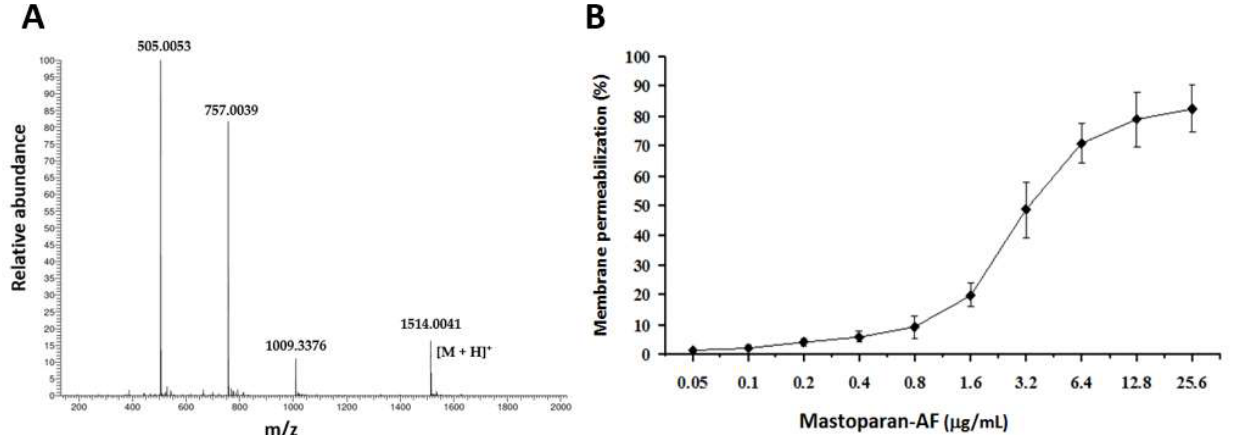
Figure 2. Mass spectrometry (MS) and membrane permeabilization effect of mastoparan-AF on he- molytic E. coli O157:H7. ( A ) Mastoparan-AF was synthesized and the identity was confirmed by MS.